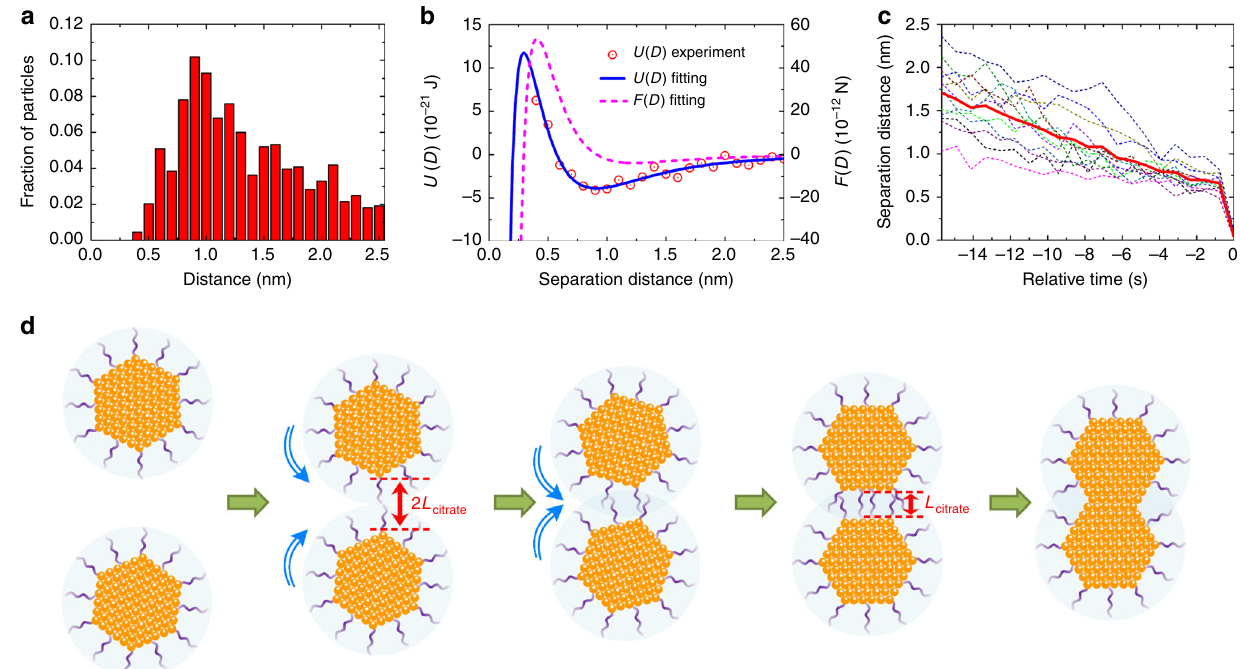
Fig. 3 Interactions between pairwise particles. a A combined statistical distribution of all surface separation distance during the process of approaching in the observed OA events by 21 particle pairs. b Interaction potential of particle pairs as a function of their separation distance. The values for the potential (red dots) are extracted from statistics in ( a ) using Boltzmann distribution: P ð D Þ ¼ C exp ð(cid:2) U ð D Þ = k B T Þ , where U ( D ) is the combined potential energy resulting from the steric-hydration repulsive force and the van der Waals attractive force. The fi tted potential and the corresponding force ( F ð D Þ ¼ (cid:2) d U ð D Þ = d D ) are shown by solid blue and dashed magenta curves, respectively. c Separation distance between 12 particle pairs during their approaching vs. relative time (while assuming that contact occurs at 0 s). Solid line is the average distance for these particle pairs. d Schematic illumination of the whole OA process